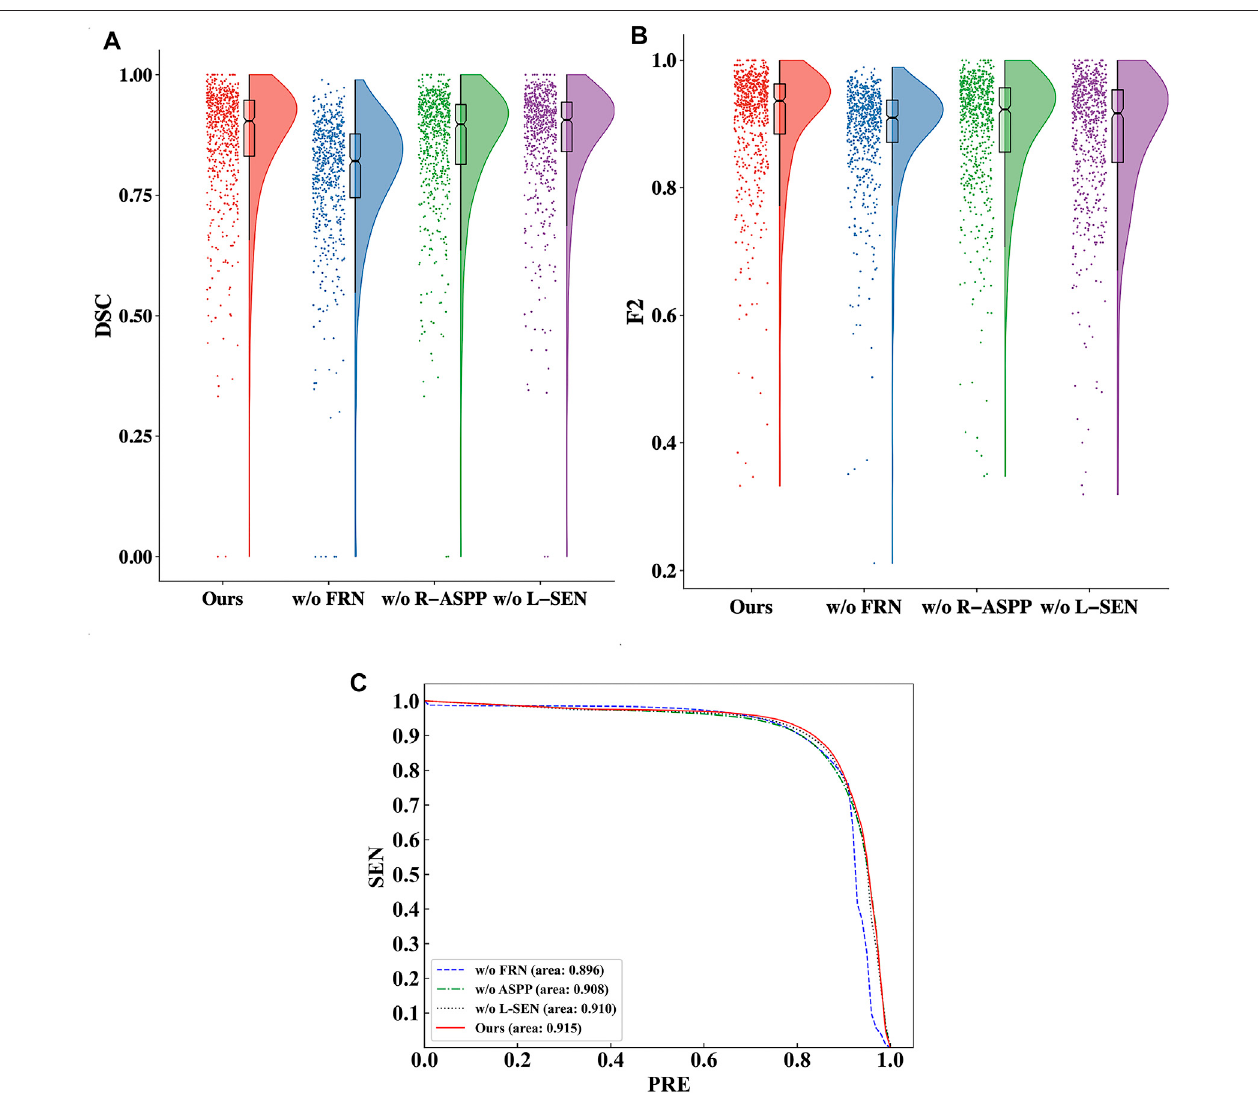
FIGURE7| Comparisonoftheeffectivenessofthefourablationcombinations. (A) ComparisonoftheDSCvaluesintheraincloudplotoftheablationcombinations. (B) Comparison of the F2 values in the raincloud plot of the ablation combinations. (C) Comparison of the P-R curves of the segmentation performance results of the ablation